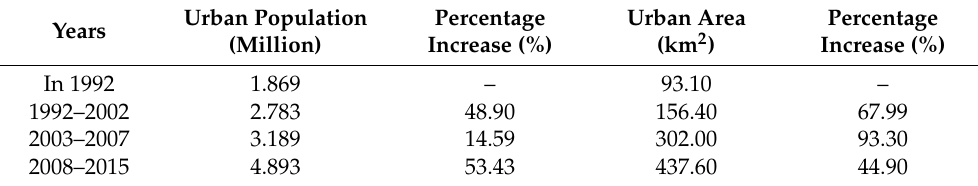
Figure 2. Level of urban development. Table 4. Changes in urban population and urban area in